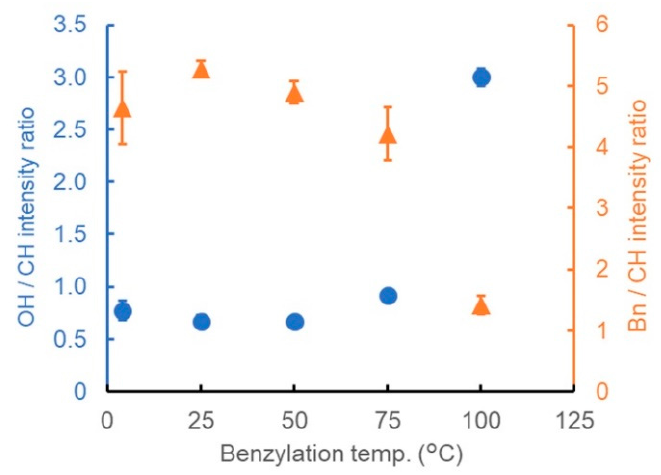
Figure 4. Ratio of the peak intensity derived from the OH groups (blue circles) or benzene rings (orange triangles) to that of CH stretching vibrations, showing the dependence of the degree of benzylation on the reaction temperature.